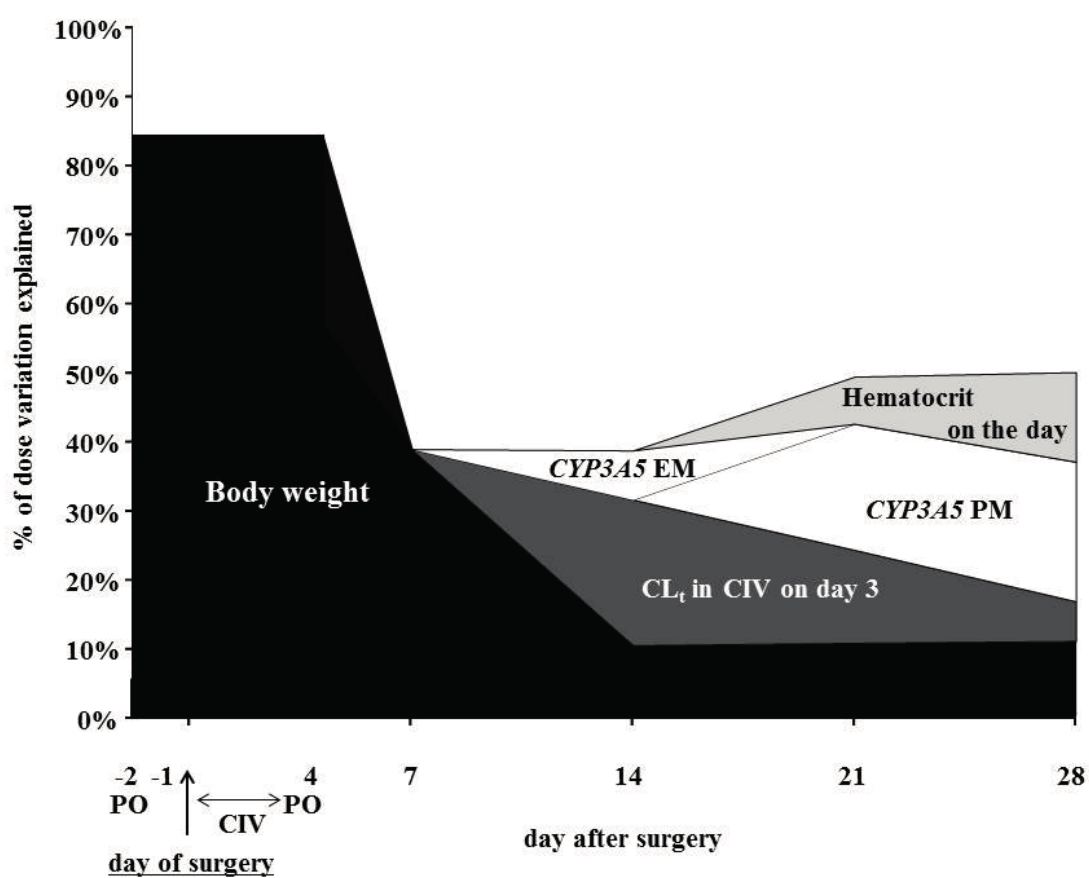
Figure 2. Percentage of dose variation for once-daily formulation of tacrolimus determined at weekly time points. CL t during CIV; total clearance of tacrolimus during continuous intravenous infusion (CIV). PO; oral administration. EM, CYP3A5*1 / *1 + *1 / *3 ; PM, CYP3A5*3 / *3